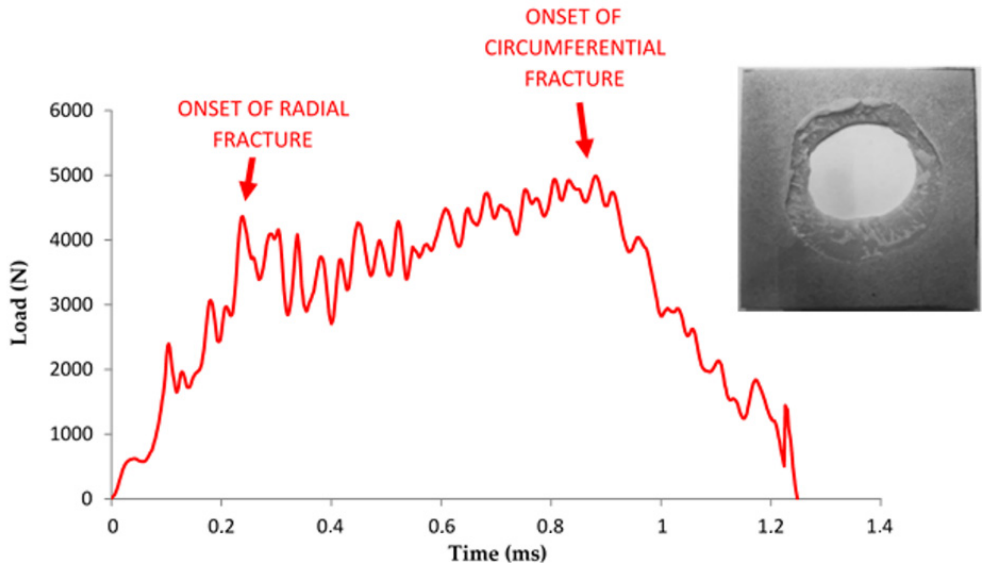
Figure 13. Correlation between fracture propagation and the Load vs. Time for PAGF matrix material.